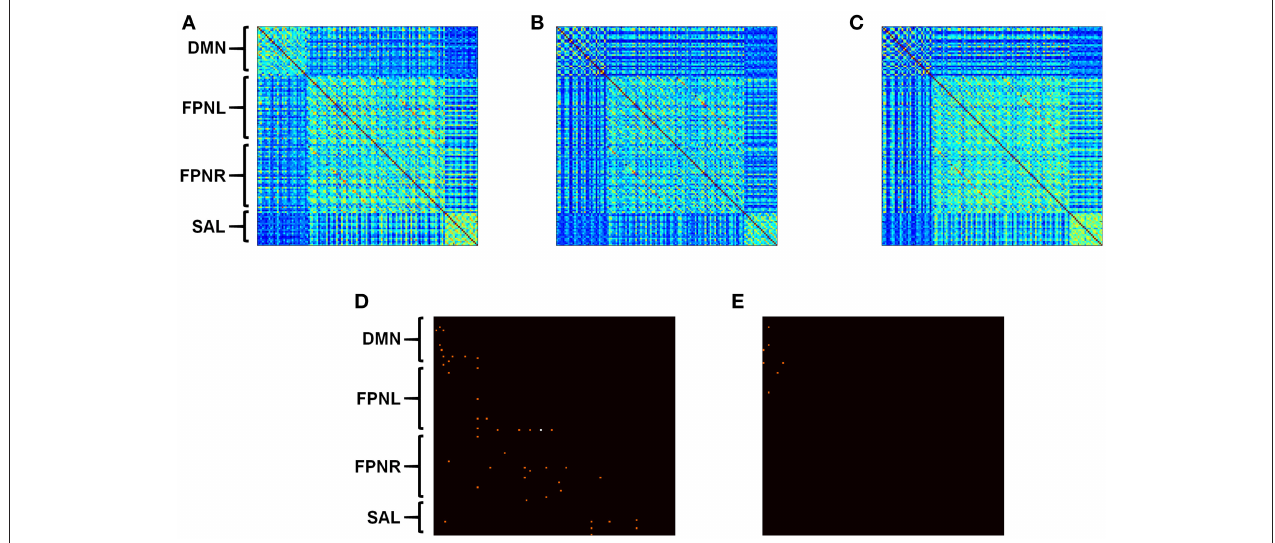
FIGURE 3 | Calculated correlation with AD progression. Average functional connectivity was calculated for all nodes in HCs (A) , aMCI (B) , and AD (C) . Connectivity matrices represent pairwise connectivity between all derived nodes. Significant differences in correlation between HCs and disease groups are shown for aMCI (D) and AD (E) . Subject group sizes included 20 HCs, 39 aMCI subjects and 24 AD patients. Connections that are significant after correction are shown in white ( α < 0.05). Uncorrected p < 0.001 is shown in orange.